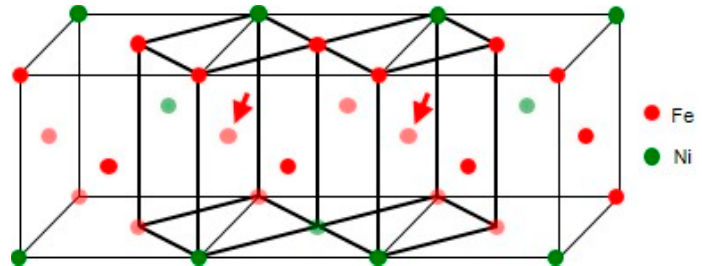
Figure 4. Example of the atom configurations for the Fe-36 wt % Ni composition. The BCT structure, as drawn by thick lines, is equivalent to the FCC structure, as drawn by thin lines. The BCT phase can be converted into the BCC phase by altering the interatomic distances without extensive atomic movement. In the configurations of Fe (red color) and Ni (green color) atoms for the Fe-36 wt % Ni (Fe-35 at.% Ni) composition, the number of nearest-neighbor Fe atoms with respect to each Fe atom, as indicated by arrows, can be either 5 for the BCC structure or 8 for the FCC structure.